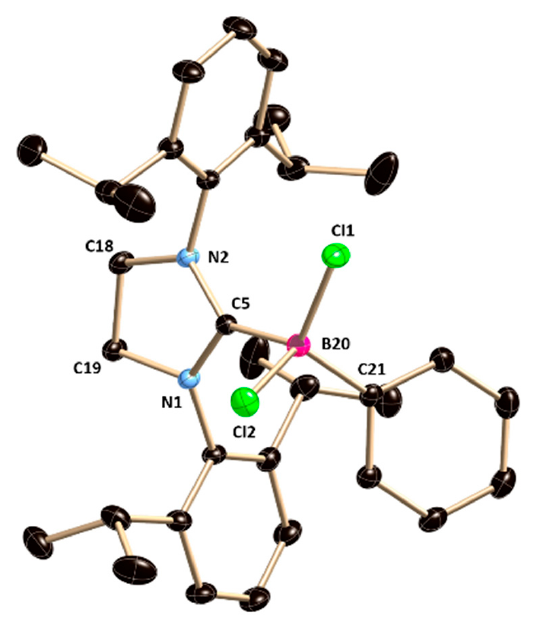
Figure 2. The molecular structure of 2 . Hydrogen atoms are omitted for clarity. Selected bond lengths [Å] or angles [deg]: C5–N1 1.3403(8), C5–N2 1.3443(8), C19–N1 1.4810(9), C18–N2 1.4756(9),